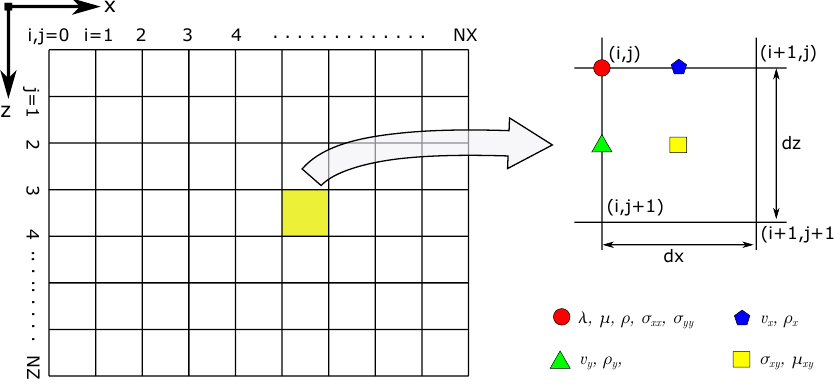
Figure 3. A staggered grid configuration for use in seismic finite difference modelling